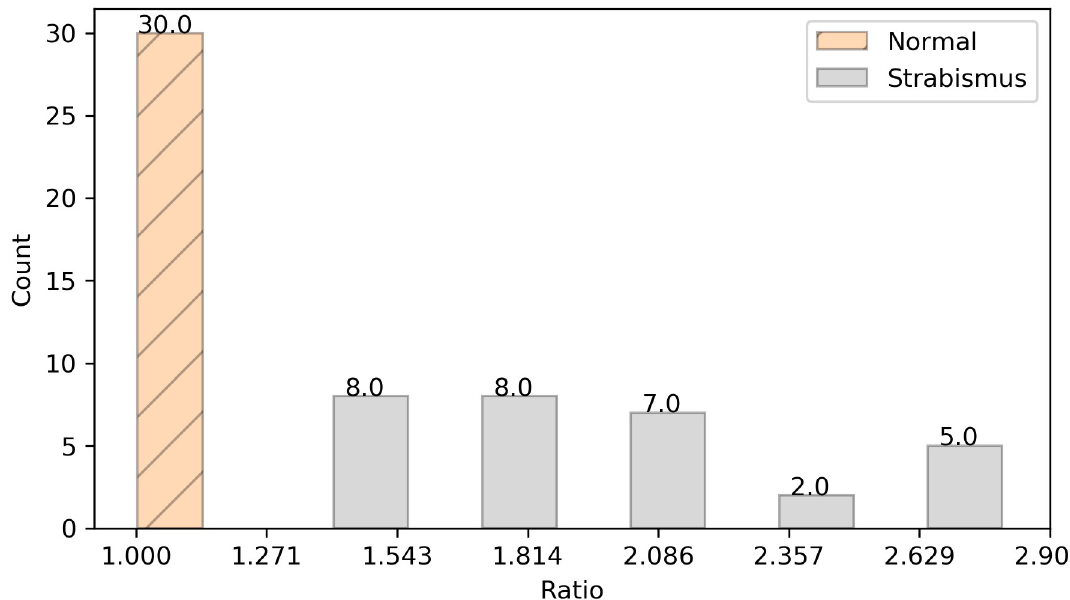
Fig 5. Distribution of position similarity ratio for normal and strabismic